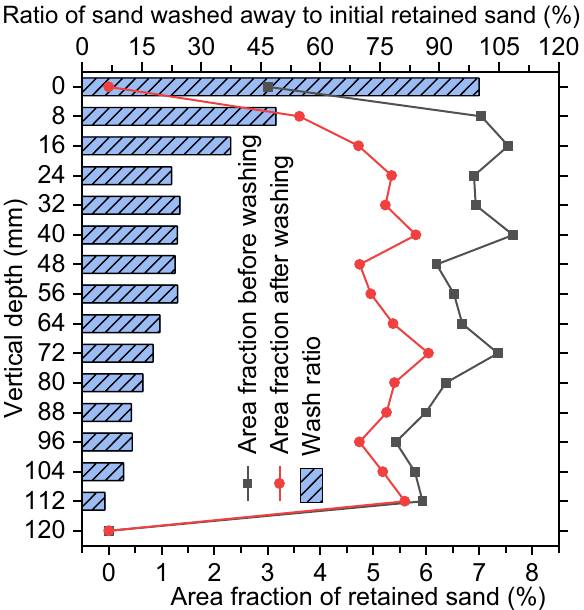
Figure 9. Vertical distributions for the area fraction of retained sand before any washing and after 30 washing cycles (line graph) and vertical distribution for the wash ratio of sand (bar graph) for the medium sand-clogged sample.